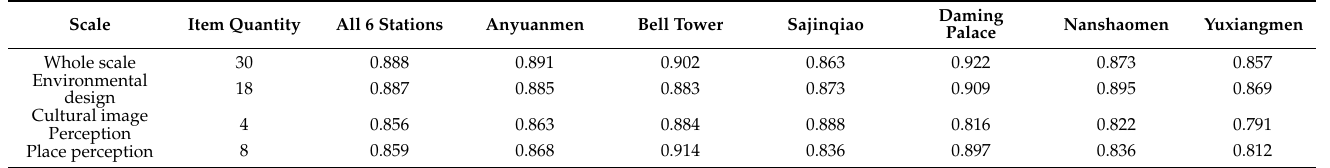
Figure 5. Results of demographic statistics. Table 6. Results of reliability tests of the evaluation scale for the six sample stations and all six combined.